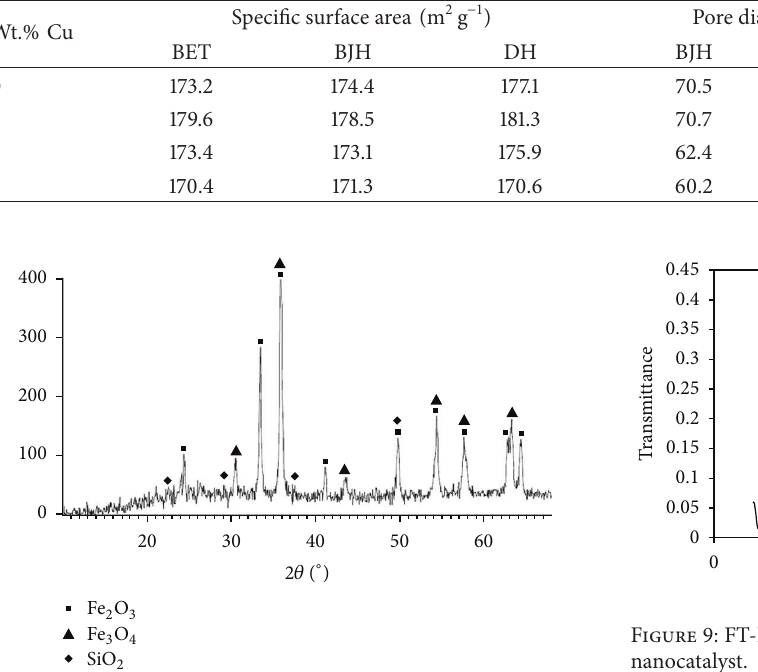
Figure 8: XRD patterns of the Fe-V/SiO 2 promoted with copper nanocatalyst.